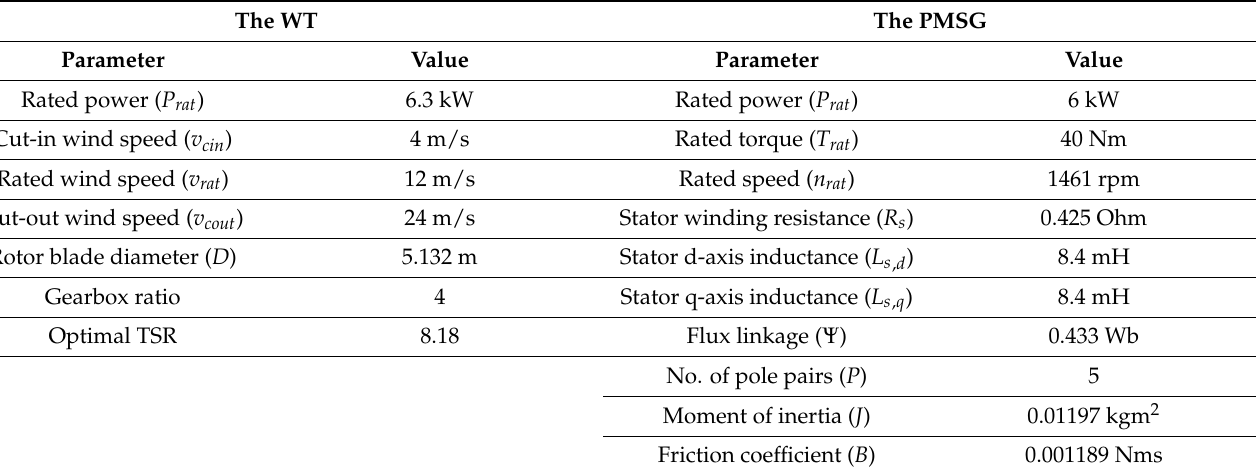
Table 2. The WTG system parameters.